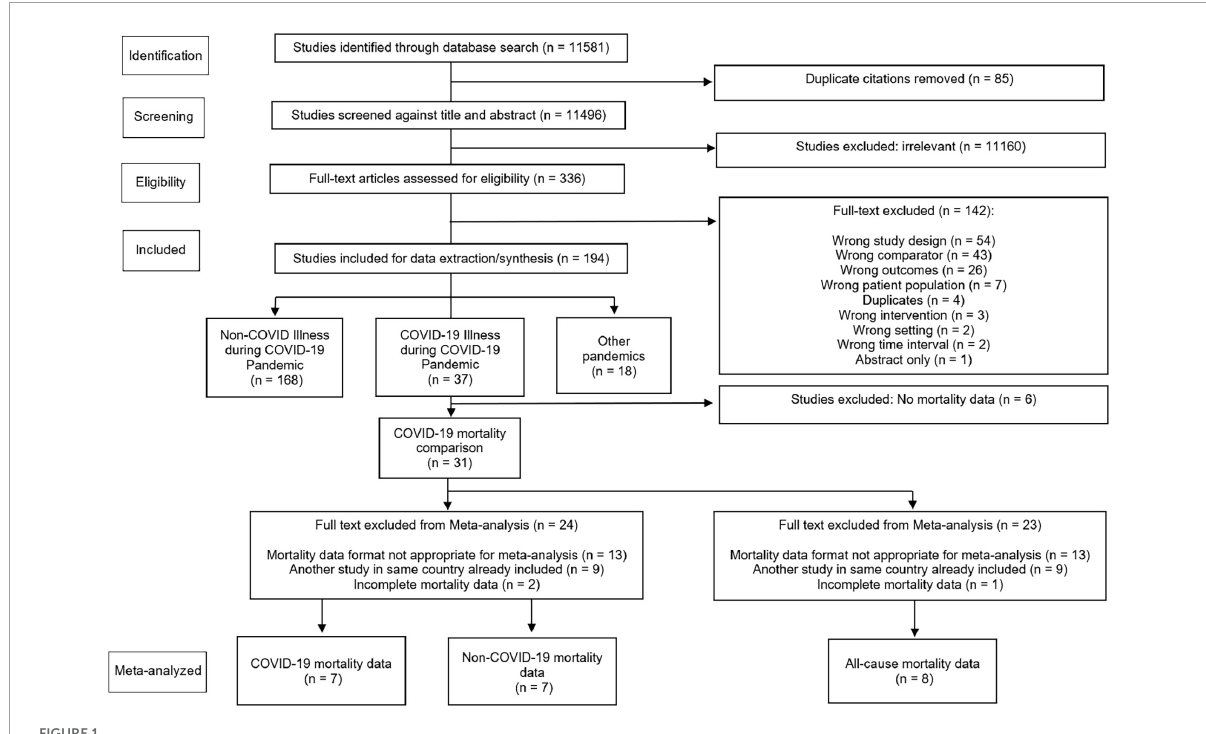
FIGURE1 COPES PRISMA flow